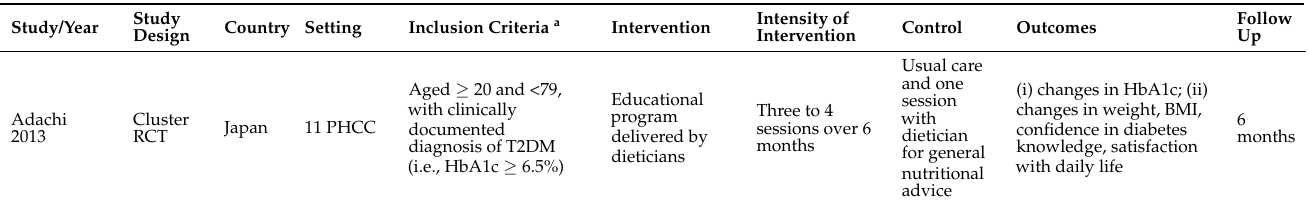
Table A2. Characteristics of included studies according to the eligibility criteria for studies offering nutritional therapy primarily for type 2 diabetes